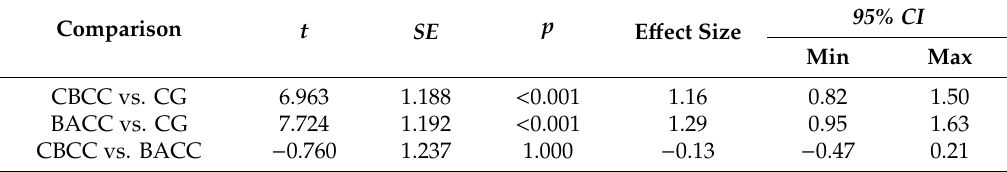
Table 3. Pairwise comparison of intervention e ff ects on post-intervention CES-D.